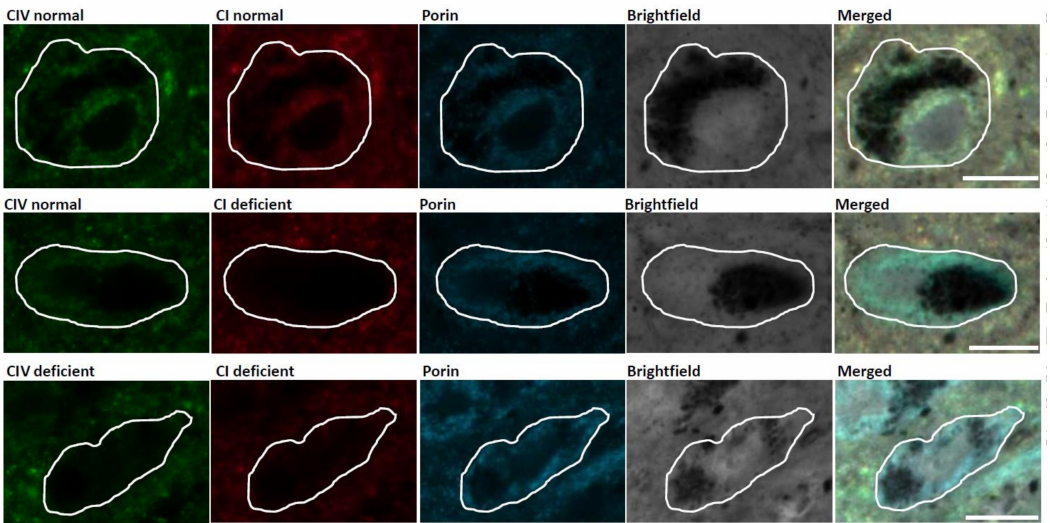
Figure 1. Mitochondrial respiratory chain (RC) deficiency in substantia nigra (SN) neurons of an individual with Parkinson’s disease (PD). Immunofluorescent images demonstrating SN neurons with normal Complex I (CI) and Complex IV (CIV) expression, Complex I deficiency and normal Complex IV expression, and deficiency of both Complex I and Complex IV. Scale bar, 20 µ